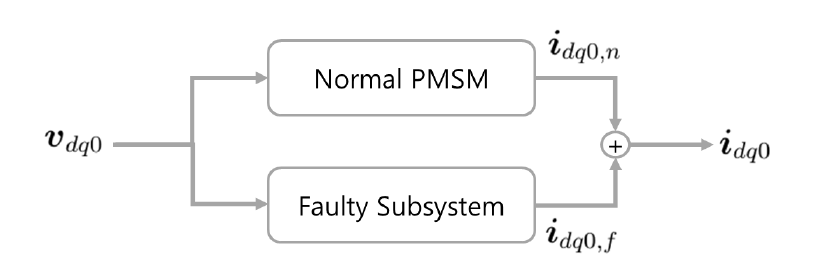
Figure 2. Two subsystems of PMSM under interturn short-circuit